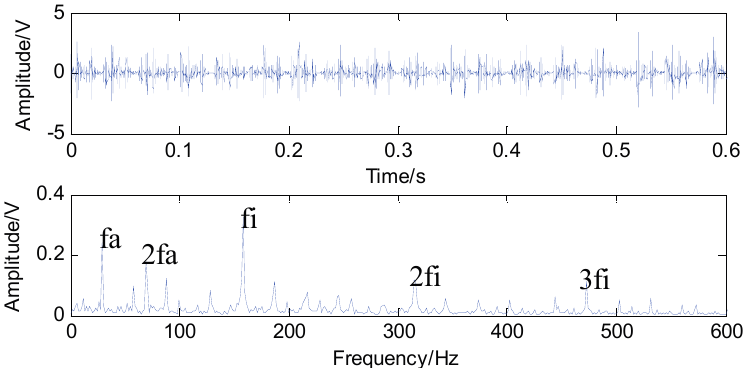
Figure 9. Time waveform of the original signal with an inner race defect ( a ); and the spectrum of the original signal ( b ).